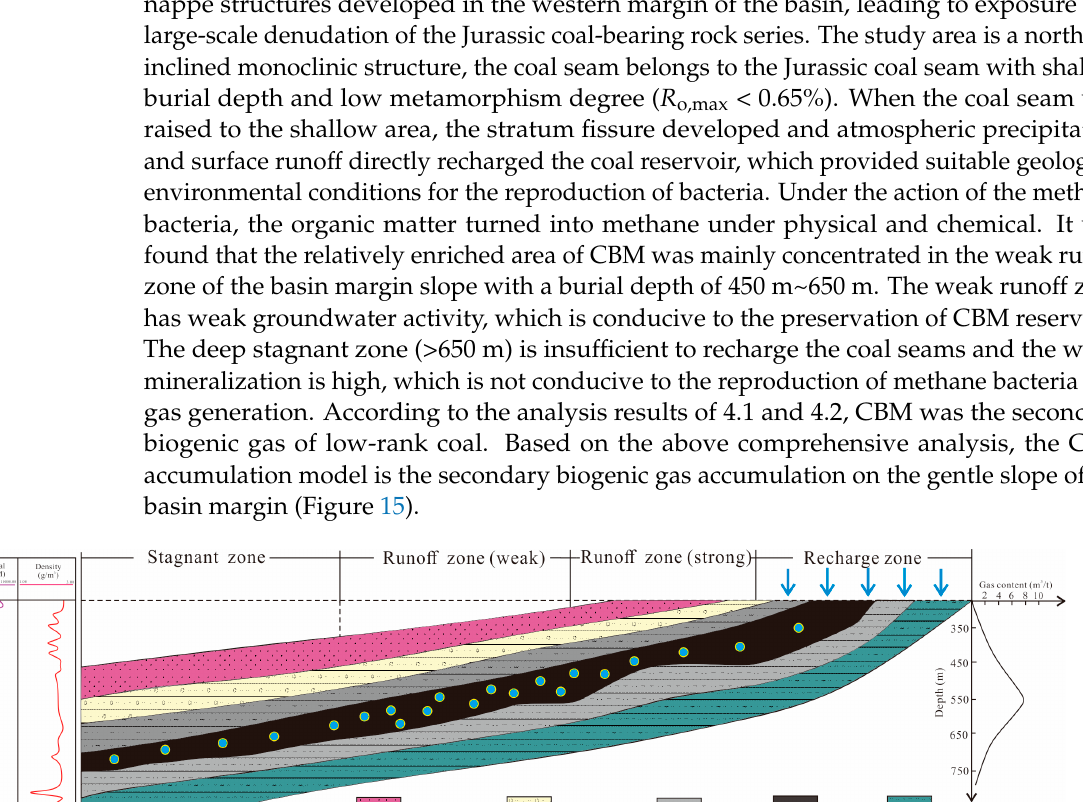
Table 5. Grey correlation quantitative evaluation of controlling factors of CBM production. Vertical Well